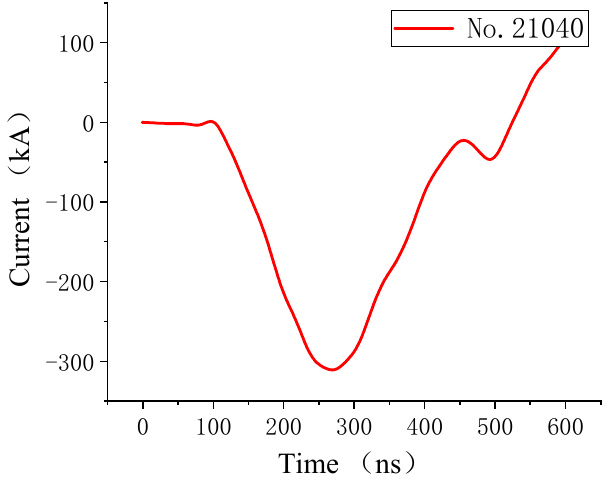
Figure 5. Electron beam current waveform (No. 21040).